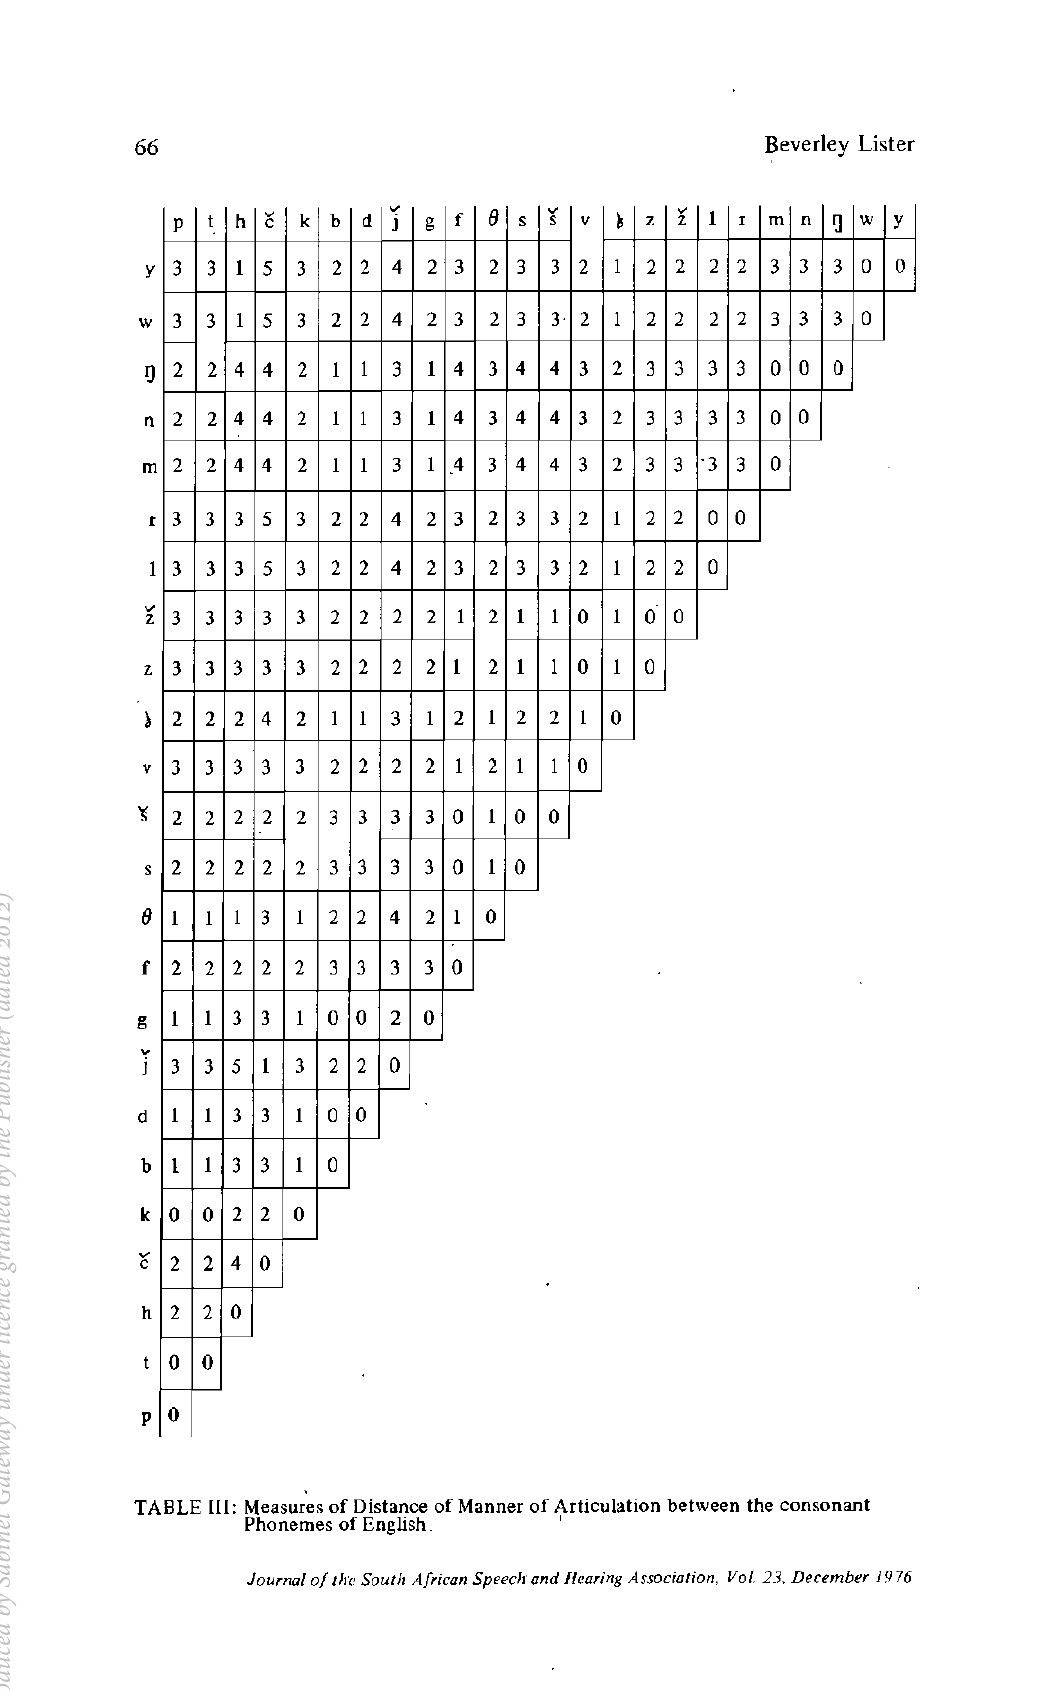
TABLE III: Measures of Distance of Manner of Articulation between the consonant Phonemes of